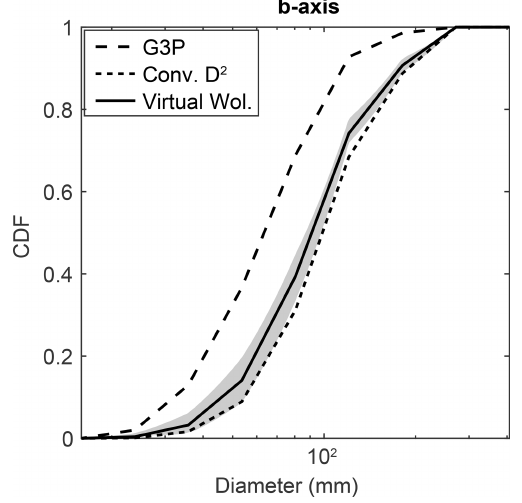
Figure 8. Illustration of conversion from a G3Point grain-size dis- tribution to a Wolman-like distribution. Data are from Site 2 of Château Renard. The initial G3point distribution is an area-by- number one (large dashed line) that can be converted to a grid-by- number (e.g., Wolman) one with a conversion factor of 2 (small dashed line). Alternatively, a virtual Wolman count can be per- formed directly on the segmented and fitted grains (black line). The shaded envelope indicates the variability observed with 50 realiza-